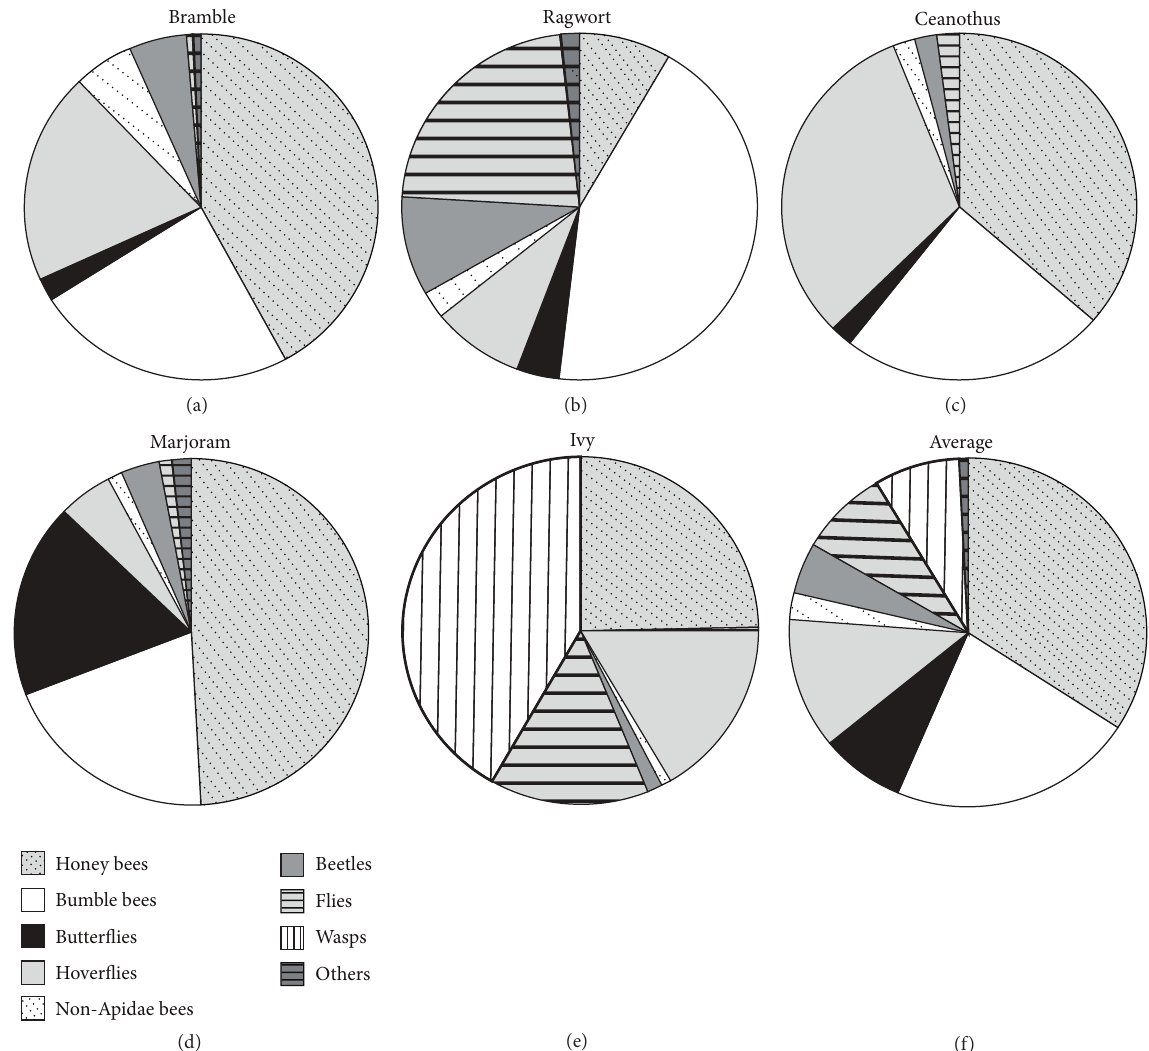
Figure 2: Eight main insect groups were commonly found on all plants in varying proportions. Daily census data were taken on (a) bramble, 𝑛 = 900 ; (b) marjoram, 𝑛 = 1300 ; (c) ragwort, 𝑛 = 800 ; and (d) ivy, 𝑛 = 700 . California lilac (e) census was inferred from the pilot rate data ( 𝑛 = 99 ). Averages (f) were taken across all the data. The “Others” category, which was infrequent ( < 2% of all collected census data), included ants ( 𝑛 = 6 ), mirid bugs ( 𝑛 = 5 ), a lacewing ( 𝑛 = 1 ), and moths ( 𝑛 = 28 ). Overall we took a census on 37 study days across four plants ( 𝑛 = 3700 for bramble, marjoram, ragwort, and ivy plus 𝑛 = 99 for California lilac). Honey bees were the most frequent insect observed (34%), followed by the bumble bees (22%) and hoverflies